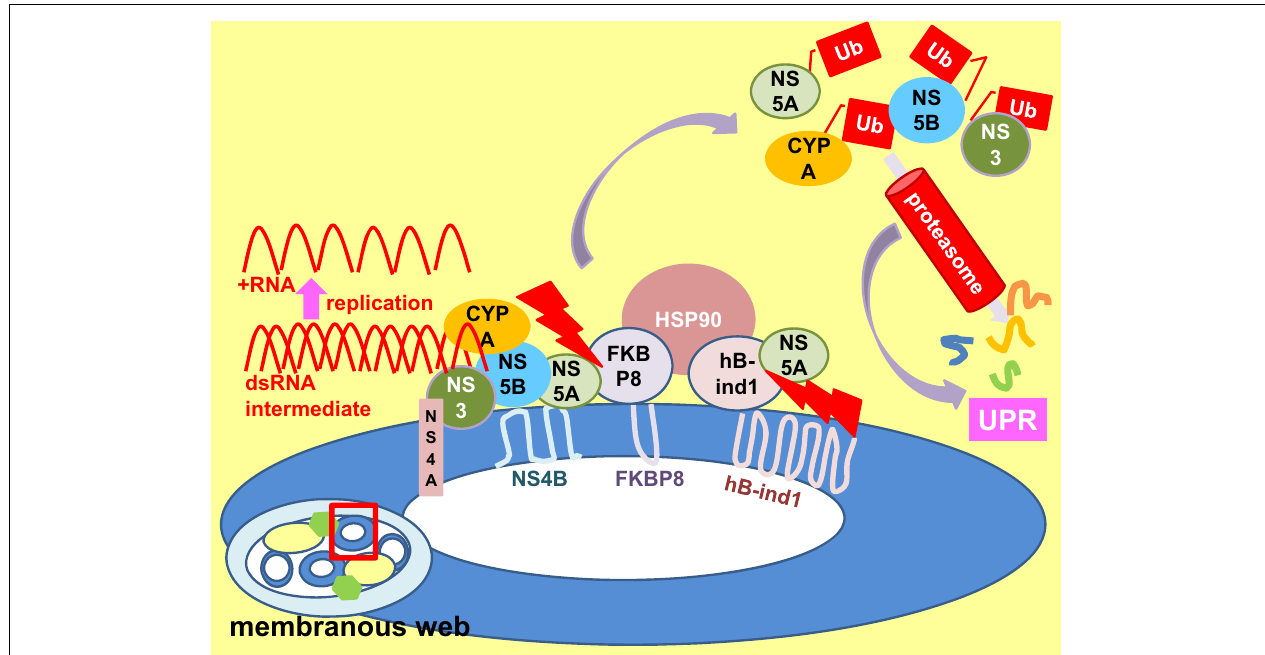
FIGURE 7 | Perturbation of replicase chaperone activity results in UPR. An enlarged view of a membrane vesicle (enclosed by a red square) within the membranous web. Heat shock protein 90 (HSP90) chaperones folding of viral non-structural (NS) 3-NS5B proteins and host protein cyclophilin A (CYPA) etc. in the replication complex to facilitate viral replication. HSP90 forms a complex with NS5A via interactions with its co-chaperone